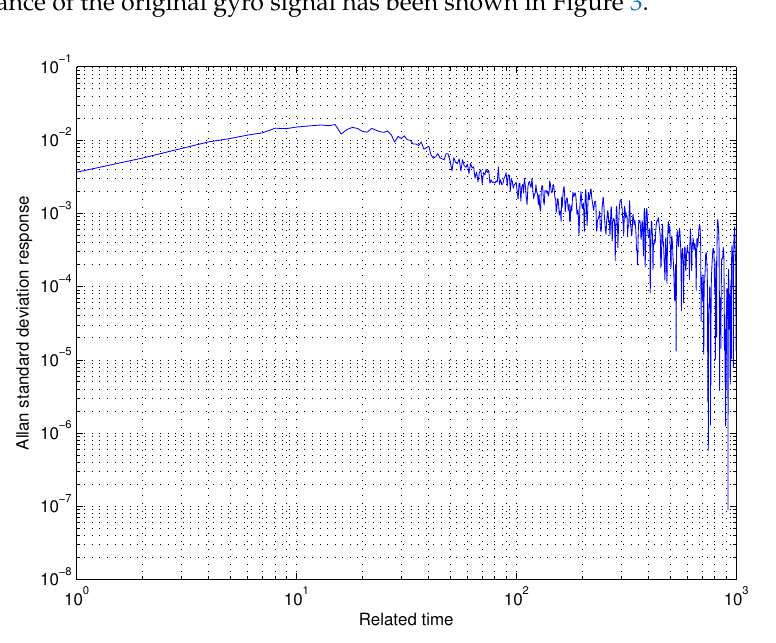
Figure 3. ALLAN variance of the original gyro